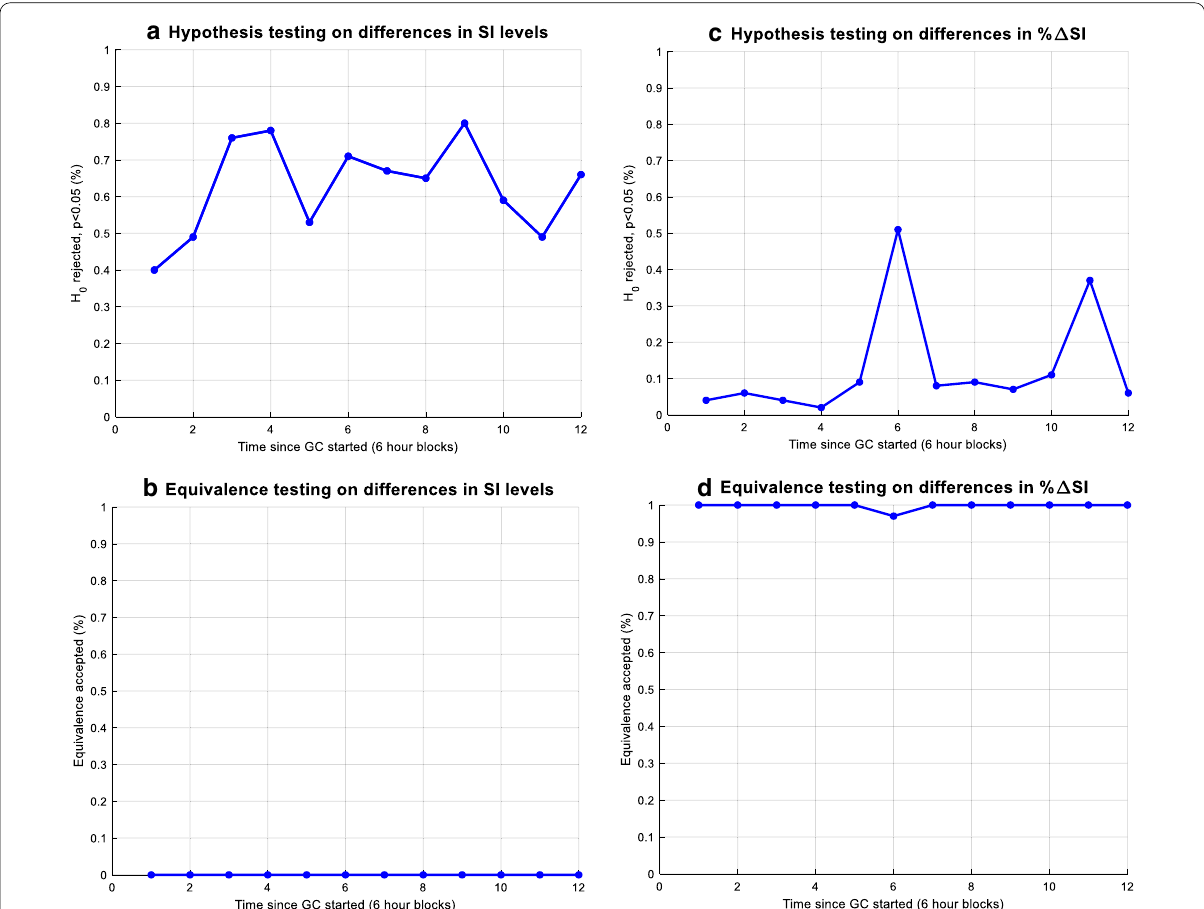
Fig. 8 Hypothesis and equivalence testing using 6-h blocks from 100 resampled male and female (N